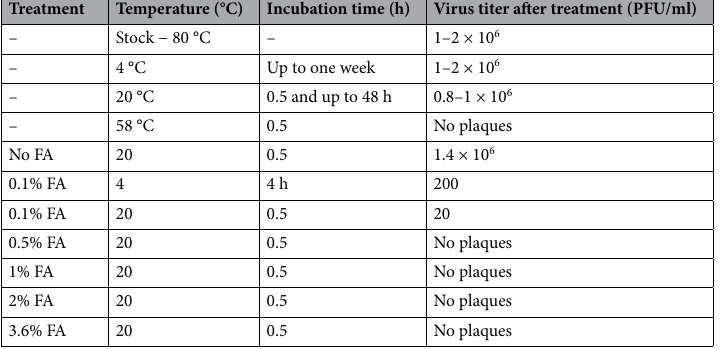
Table 1. Efficiency of SARS-CoV-2 inactivation by FA in relation to temperature and incubation time. Virus titer was determined by plaque assays (see Supplementary Figure